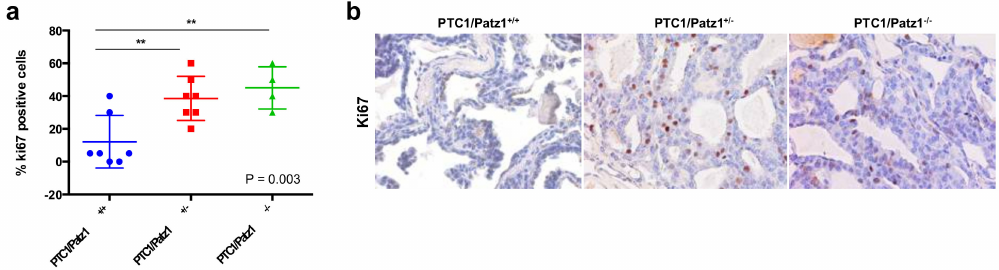
Figure 4. ( a ) Percentage of tumor cells stained positively for Ki-67 proliferation marker in RET/PTC1 TG mice with different Patz1 genotype. Differences among means were statistically significant, according to one-way ANOVA analysis of variance ( p value is indicated on the bottom-right corner of the graph). ** p < 0.01, according to Tukey’s multiple comparisons test. n = 7 for either RET/PTC1 TG ;Patz1 +/+ or RET/PTC1 TG ;Patz1 +/ − and 4 for RET/PTC1 TG ;Patz1 − / − ; ( b ) Representative Ki-67 staining of thyroid carcinomas from RET/PTC1 TG ;Patz1 +/+ , RET/PTC1 TG ;Patz1 +/ − , and RET/PTC1 TG ;Patz1 − / − mice. Original magnification: × 40.